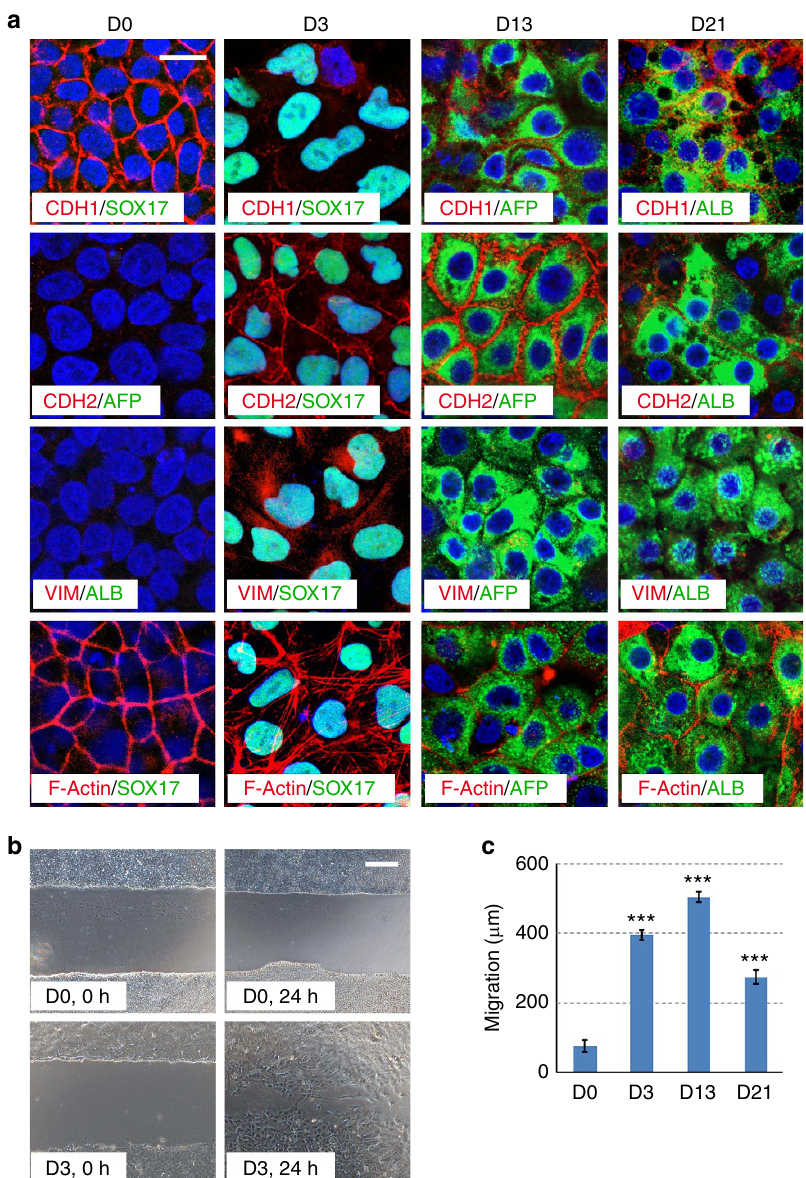
Figure 2 | An epithelial–mesenchymal–epithelial transition during the hepatic differentiation of hESCs. ( a ) Immunofluorescence staining of EMT and cell fate markers at the indicated differentiation stages. Scale bar, 20 m m. ( b , c ) Migration assays for hESC and DE cells. Scale bar, 100 m m. (Data represent mean ± s.d. from three technical repeats. *** P o 0.001 when compared to D0 using Student’s unpaired t